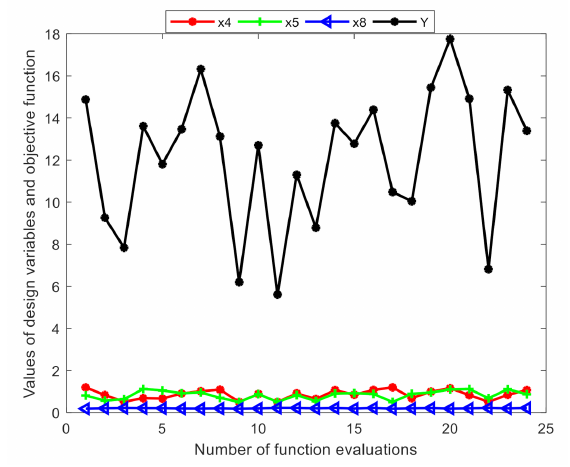
Figure 21. Trends of design variables x 4 , x 5 , x 8 and objective function obtained by HKM-HS.